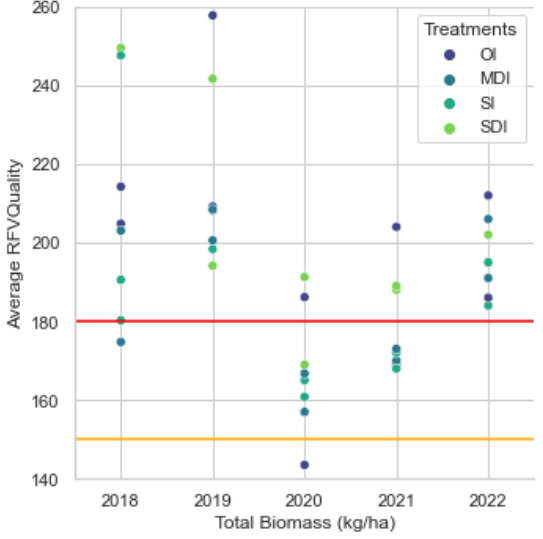
Figure 6. Inverse relationship between alfalfa dry biomass and relative feed value (RFV). Blue dots indicate RFVs for each alfalfa harvest.